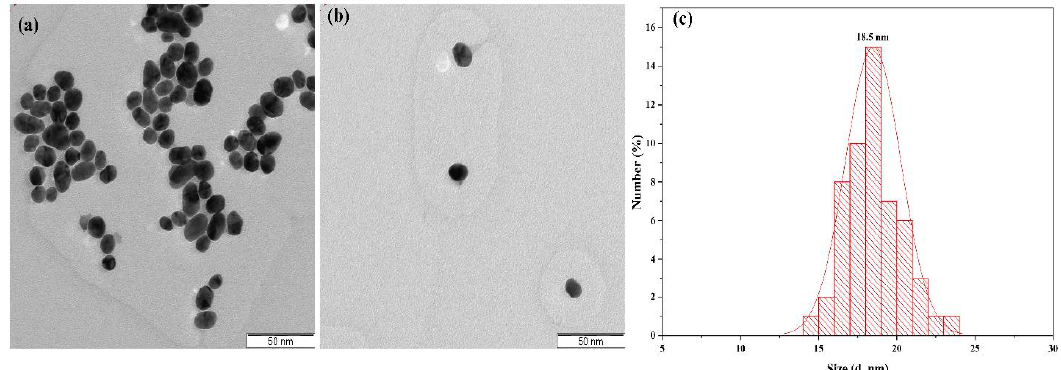
Figure 2. ( a , b ) (TEM) image with a scale of 50 nm and ( c ) size distribution of AuNPs synthesized at ultrasound output power 17.9 W·cm 2 .